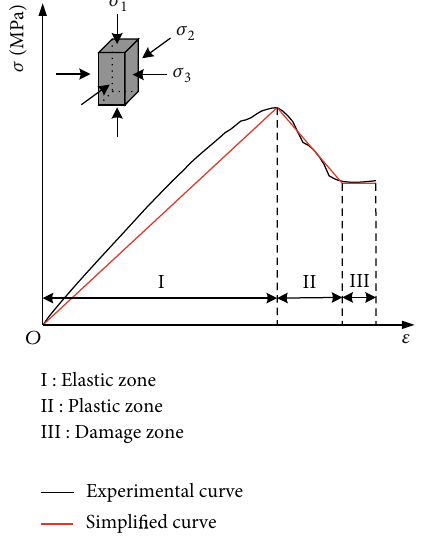
Figure 2: Total stress-strain curve of rock